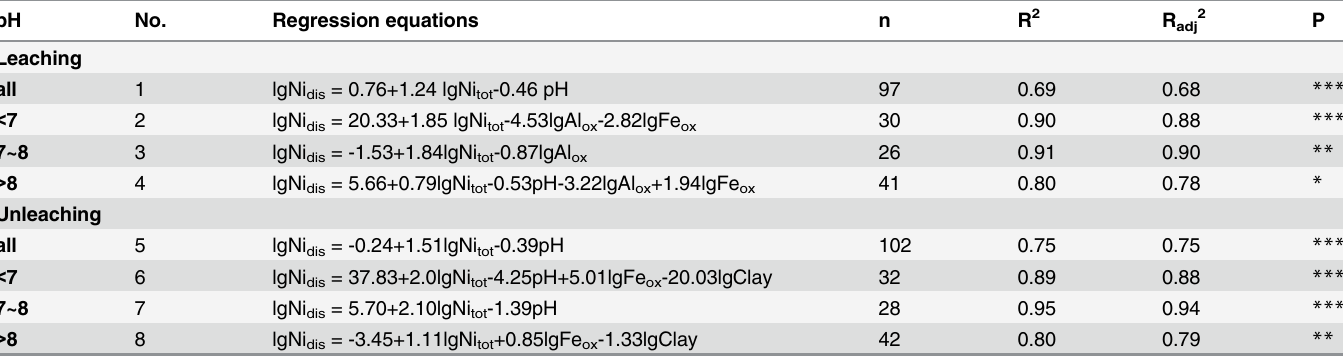
Table 2. Multiple regressions between log Ni dis (soluble Ni concentration in soil pore water) and log Ni tot (total Ni in soil) together with soil properties. pH No.